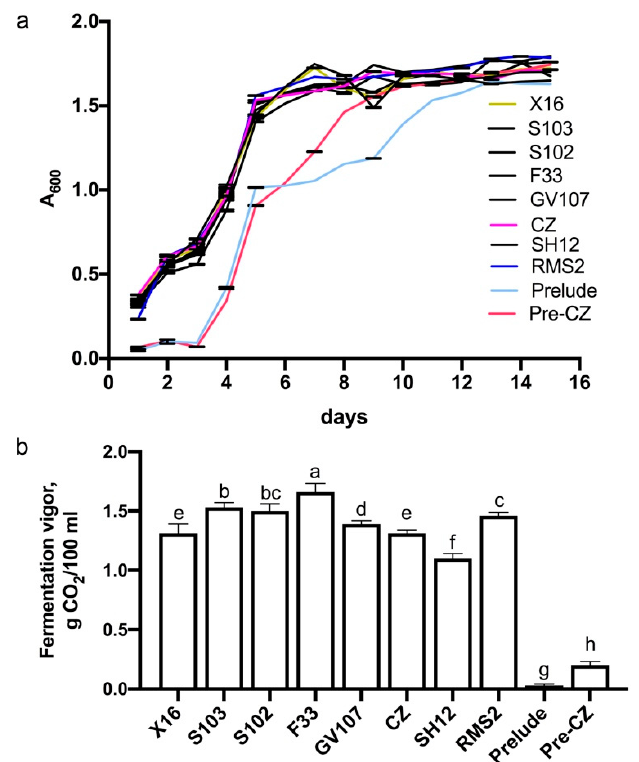
Figure 4. Growth curves ( a ) and fermentation vigor ( b ) of yeast strains. Different lower letters in ( b ) above the standard deviation bar indicate significant difference ( p ≤ 0.05).